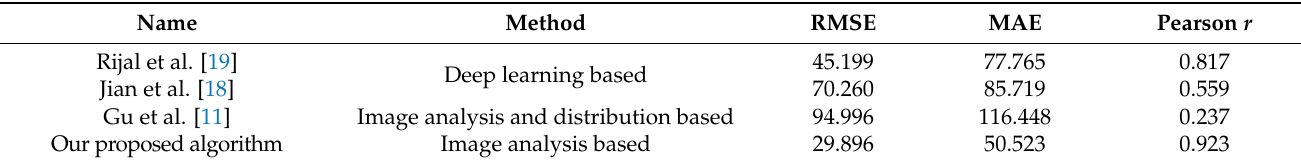
Table 2. Root-mean-squared error, mean absolute error, and Pearson correlation of PM 2.5 estimates based on the PhotoPM-daytime